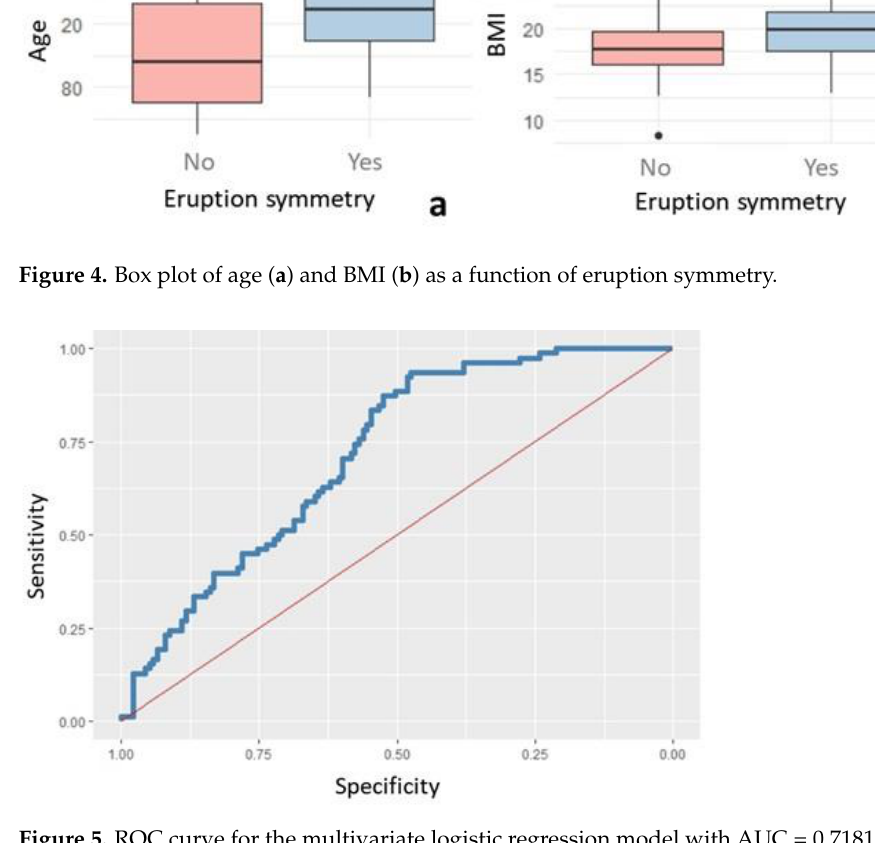
Figure 5. ROC curve for the multivariate logistic regression model with AUC = 0.7181 for eruption symmetry. 70% of the sample was used as training and 30% as testing, obtaining a correct classification of 67.28% of the individuals.